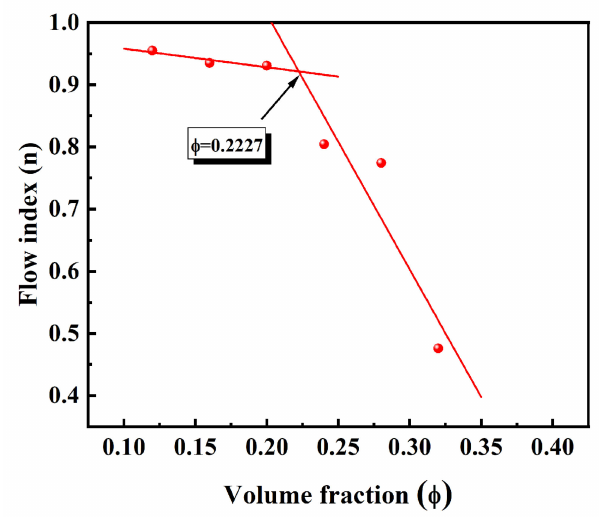
Figure 11. The plot of the flow index factor as a function of ceramic content for PVP-stabilized suspensions at an optimum PVP amount.